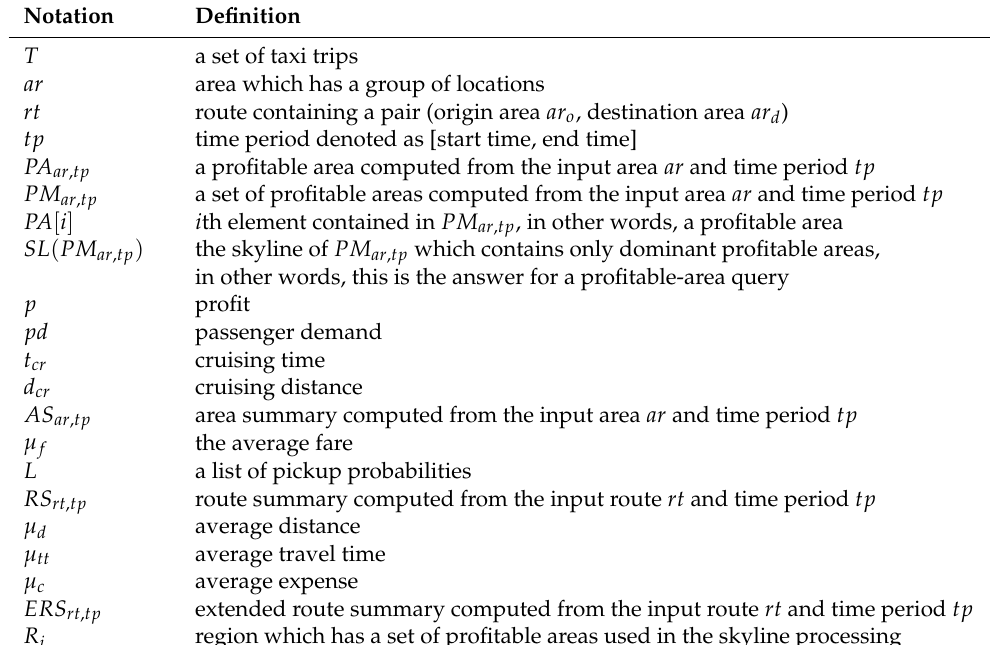
Table 1. Frequently used